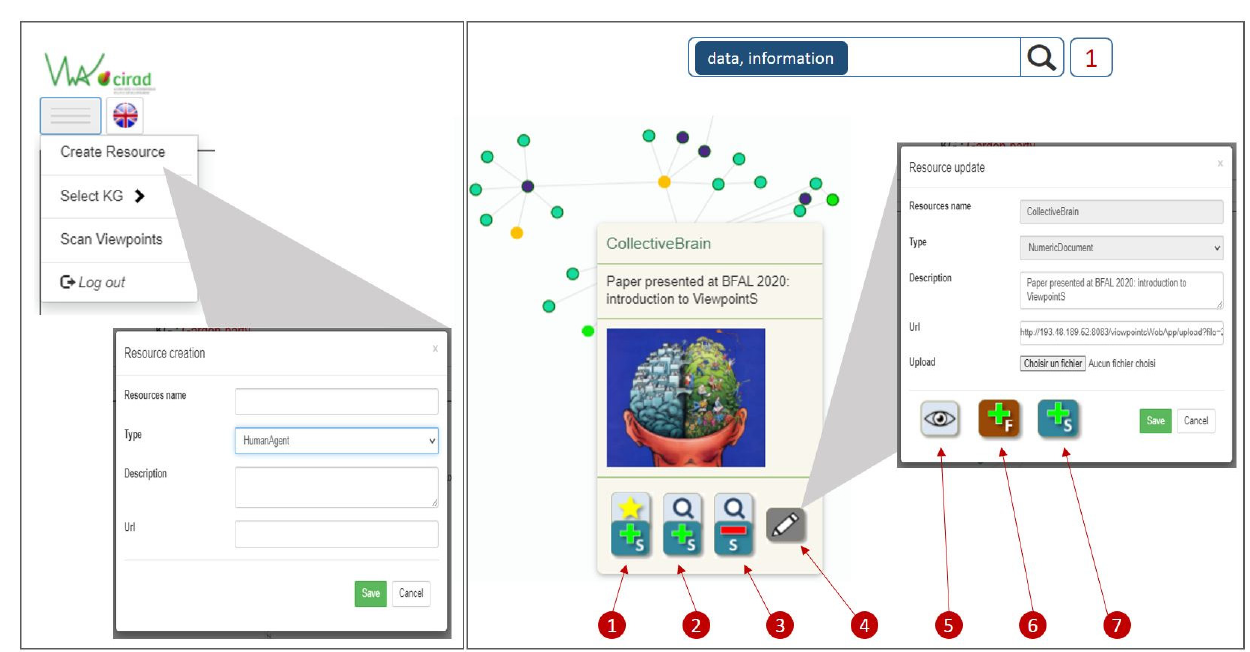
Figure 4. How the community members read in the medium. Left part: creating resources via the VWA menu. Right part: interconnecting resources via dedicated buttons.